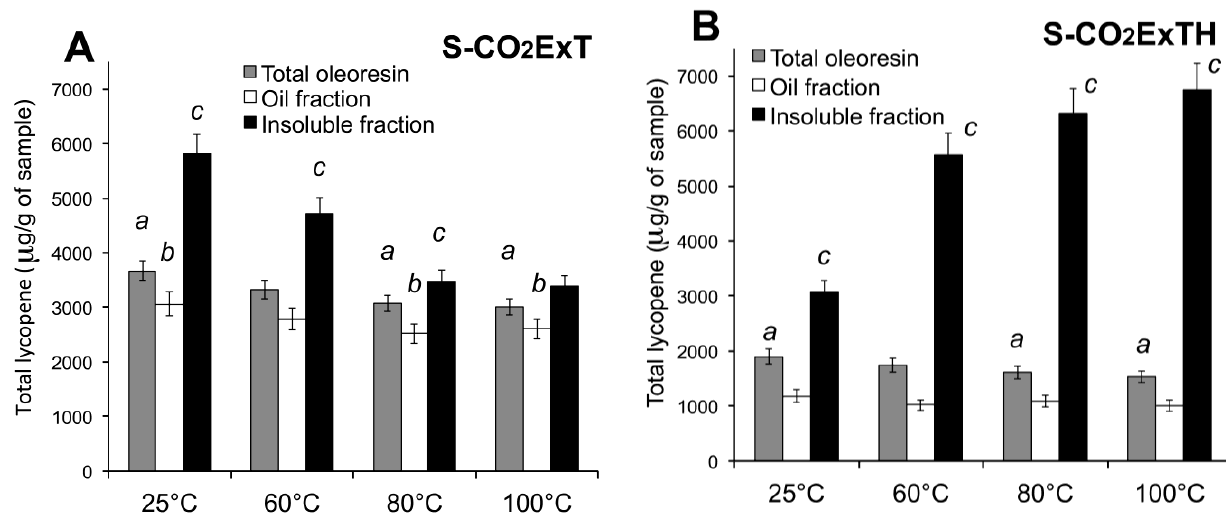
Figure 5. Effect of temperature on lycopene content in the oil and insoluble oleoresin fractions. ( A ) S-CO ExT, oleoresin extracted from pure tomato powder; ( B ) S-CO 2 oleoresin extracted from tomato/hazelnut powder. Data are mean ± SD of three measures from three independent